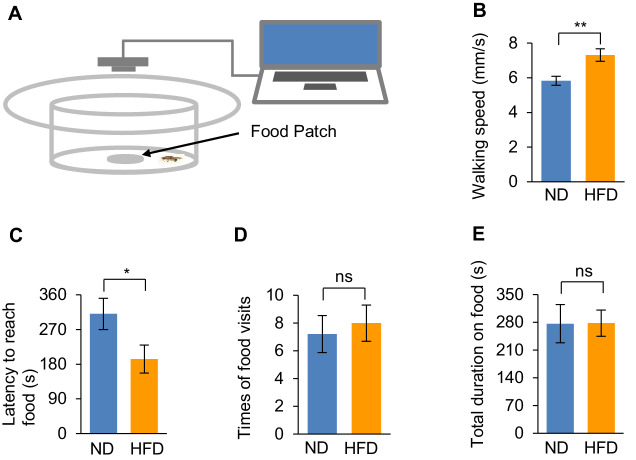
HFD feeding enhanced starvation-induced food seeking.(A) Schematic diagram of the video recording-based food seeking assay. Briefly, individual flies starved for 24 hr were introduced into a behavioral chamber with a small food patch (5% sucrose) located in the center, and their positions and moving trajectories were recorded by a camera placed on top and analyzed by a custom computer program. (B–C) Average walking speed before locating the food source (B) and latency to reach the food source (C). (D–E) Total number of food visits (D) and total duration on food (E) of starved flies during the 30 min assay. n = 14–19. Student’s t-test was used for pair-wise comparisons.